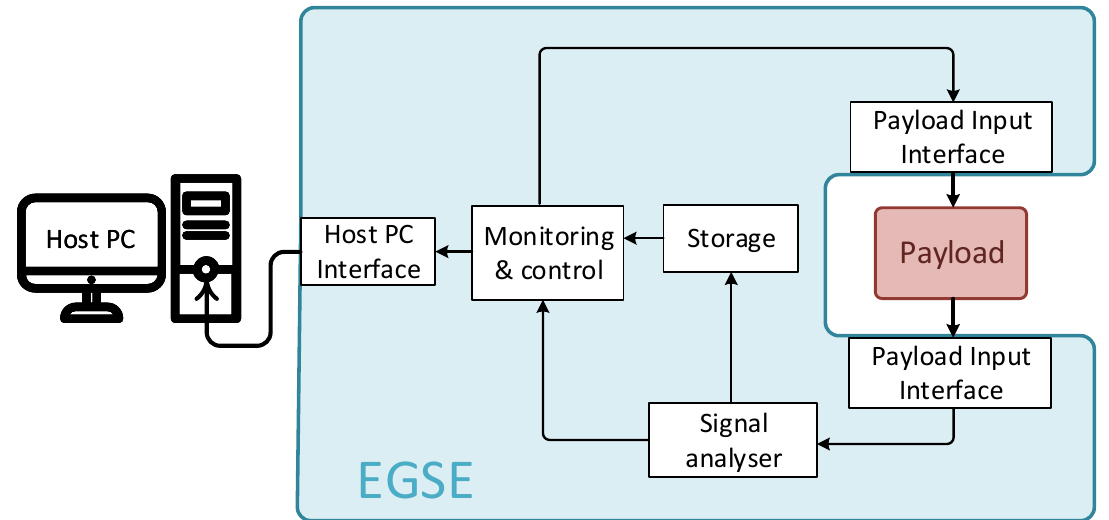
Figure 1. Electrical ground segment equipment generic block